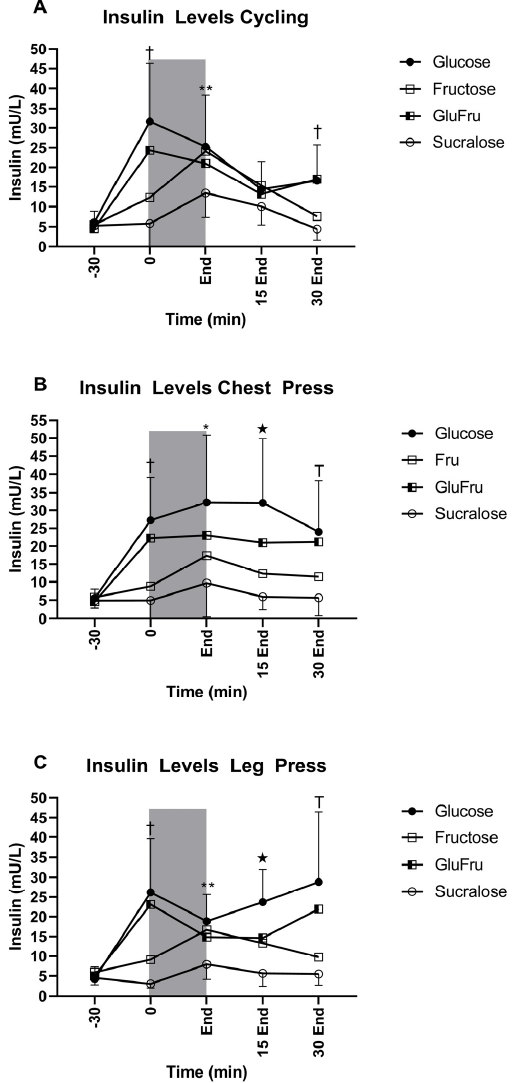
Figure 3. Black circles indicate Glu. Open Squares indicate fru. Half open squares indicate GluFru. Open circles indicate sucralose. Dark grey areas indicate exercise testing. ( A ) Insulin levels during cycling study visits † indicates statistical significance of glucose and GluFru compared to Fructose and sucralose ( p < 0.01). ** indicates statistical significance of Glu, Fru, and GluFru compared to sucralose ( p < 0.01). ( B ) † indicates statistical significance of glucose and GluFru compared to Fructose and sucralose ( p < 0.01). * indicates statistical significance of Glu, Fru, and GluFru compared to sucralose ( p < 0.01). Glu is significantly different to Fru ( p < 0.05). Stars indicate statistical significance between all substances ( p < 0.01). T indicates statistical difference between all substances besides Glu and Glufru ( p < 0.01). ( C ) † indicates statistical significance of glucose and GluFru compared to Fructose and sucralose ( p < 0.01). ** indicates statistical significance of Glu, Fru and GluFru com- pared to sucralose with no significant difference between glucose and Glufru and Fru and sucralose ( p < 0.01). Stars indicate statistical significance between all substances ( p < 0.05). T indicates statistical significance between all substances besides glucose and GluFru ( p < 0.05).